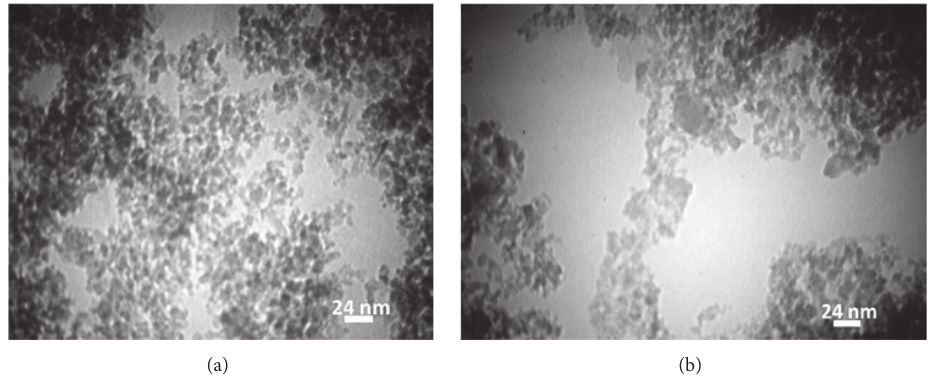
Figure 5: TEM images of (a) 𝛾 -alumina and (b) DNPH- 𝛾 -alumina.